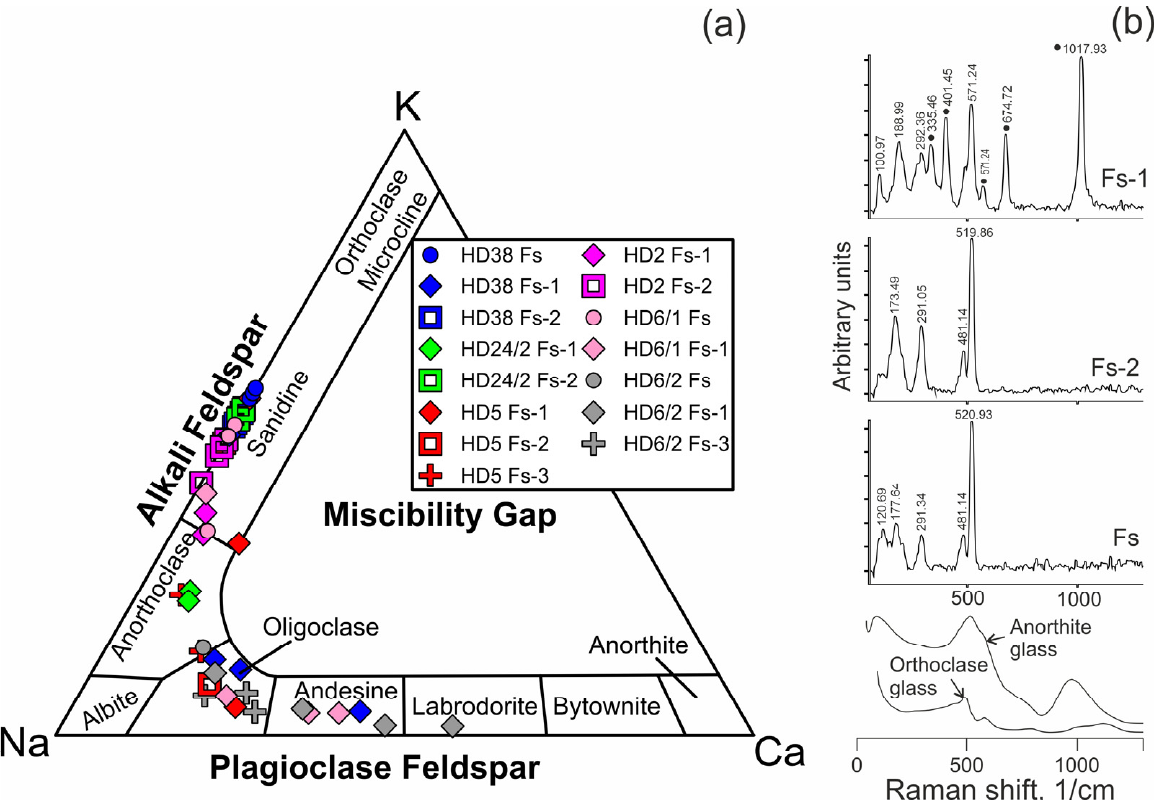
Figure 6. ( a ) Compositions of feldspar from Tumusun lherzolite xenoliths on the ternary classification diagram. Fs—feldspar from veinlets in interstitial space, Fs-1—feldspar from clinopyroxene reaction zones, Fs-2—feldspar from orthopyroxene reaction zones, Fs-3—feldspar from spinel reaction zones. ( b ) Raman spectra of feldspars from Tumusun lherzolite xenoliths. The spectrum of Fs-1 is influenced by signal of Cpx2 forming tight intergrowth with feldspar, and clinopyroxene Raman bands are marked by circles. Raman spectra of glasses of anorthite and orthoclase compositions [30] are shown for comparison.